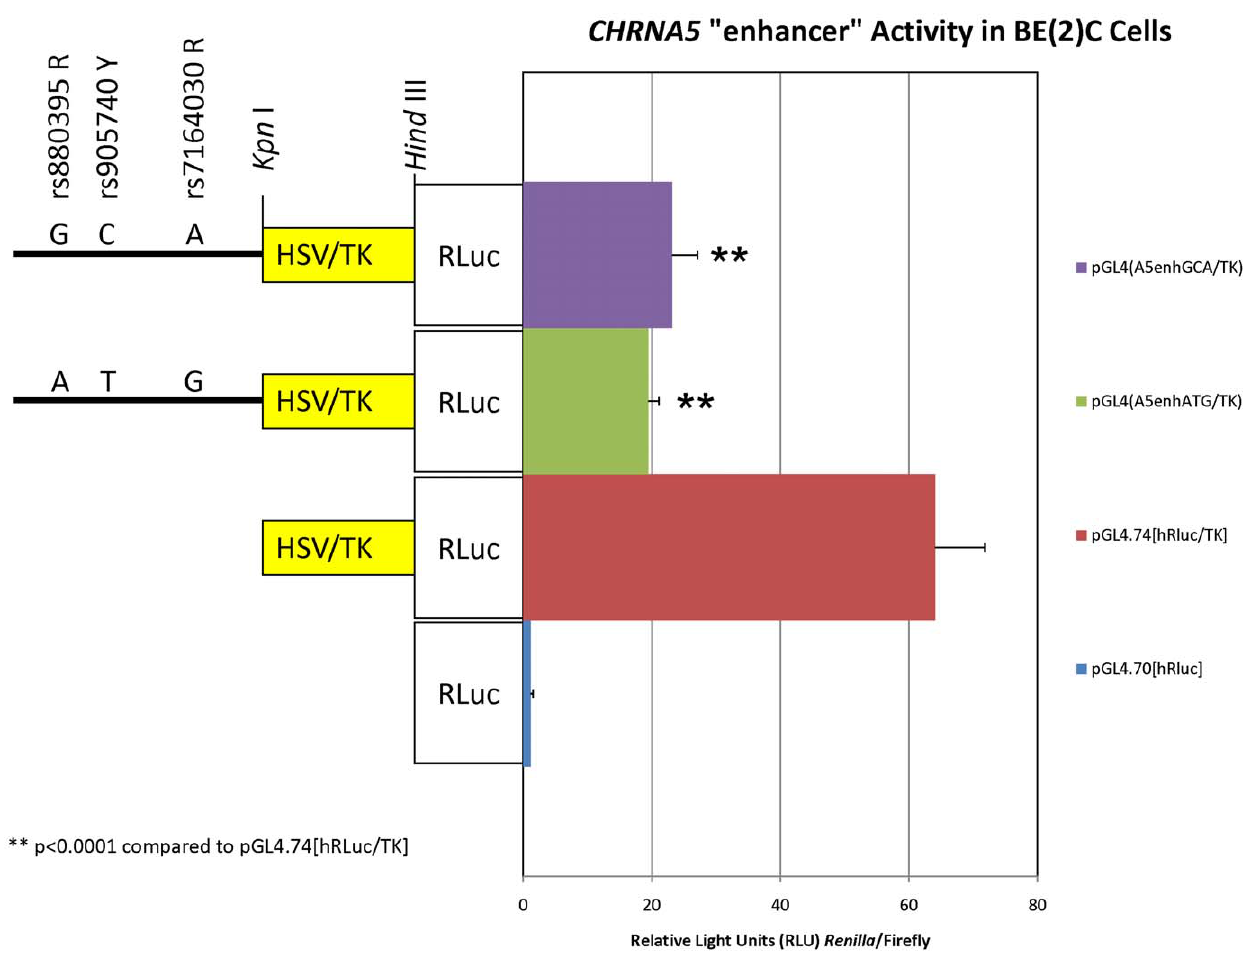
Figure 6. 5 9 distal CHRNA5 promoter element acts as transcriptional repressor. Two haplotypes of an 852 bp portion of the 5 9 distal region of the CHRNA5 promoter (13.5 kb upstream of the t.s.s.) was sub-cloned upstream of the HSV-TK promoter and transfected into BE(2)C cells. Shown are the averages 6 standard deviations of four independent experiments each done in triplicate. The HSV-TK promoter of the positive control vector pGL4.74[hRluc/TK] and experimental heterologous promoter constructs is indicated by a yellow box. The ‘‘promoterless’’ negative (background) control vector pGL4.70[hRluc] is shown without a promoter region in front of the Renilla luciferase (‘‘RLuc’’) reporter gene. The 5 9 distal region of the CHRNA5 promoter is indicated by a solid black line. The positions and identities of the rs880395 (R), rs905740 (Y) and rs7164030 (R) SNPs within each construct are indicated. Whereas the 5 9 distal element acted as a strong repressor (**p , 0.0001 compared to pGL4.74[hRluc/TK]), there were no statistically significant differences between comparisons of the two promoter haplotype constructs (p=0.183) by ANOVA with Tukey’s HSD post-hoc analysis.